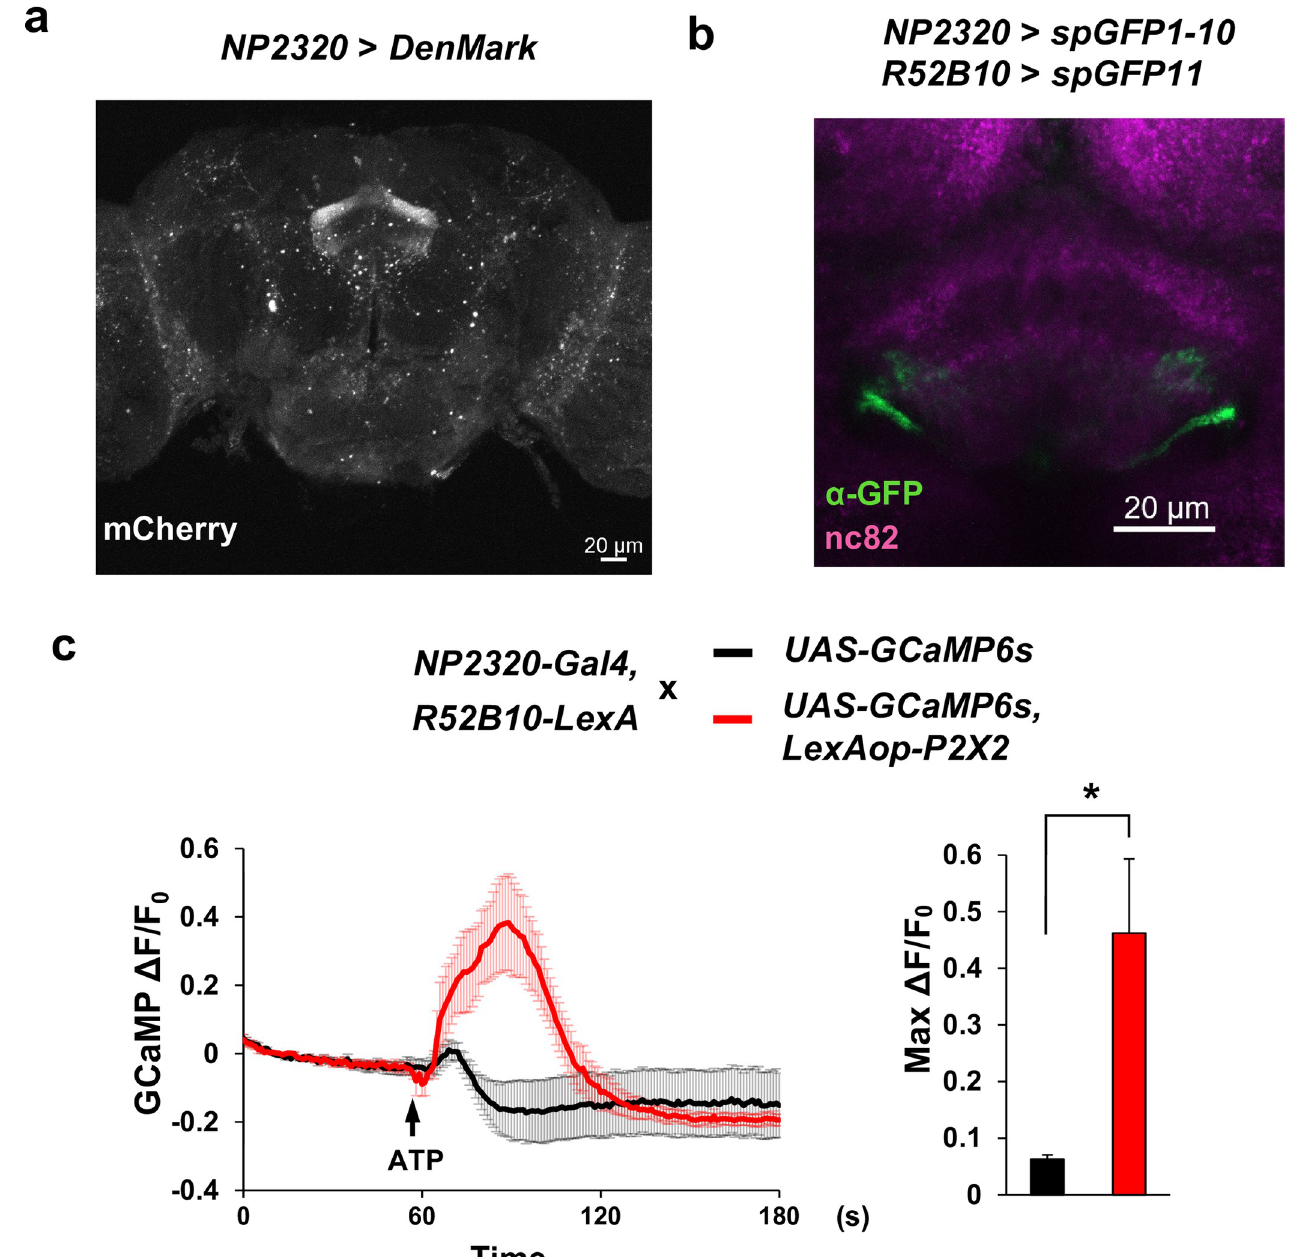
Fig 2. FB interneurons and R52B10 neurons have excitatory connections. (a) Expression pattern of the dendrite marker DenMark in FB interneurons. (b) GRASP signals between R52B10 neurons and FB interneurons labeled by NP2320. (c) left: The trace of the GCaMP signals change. R52B10 neurons that express P2X2 were activated by ATP and the GCaMP signals in FB interneurons were measured. The control group (black) and experimental group (red) were both n = 5. right: Quantification of Max Δ F/F 0 . Data are presented as mean + SEM. Two-sided Welch’s t- test was used. � P < 0.05. a clear sleep rebound in female flies but not in male flies. These results indicated that there is a sex difference in the regulation of sleep rebound, at least, in R52B10 neurons. In this study, we used only male flies and this could be one of the reasons why we didn’t observe a clear sleep rebound. We next asked about the relationship between FB interneurons and known sleep-